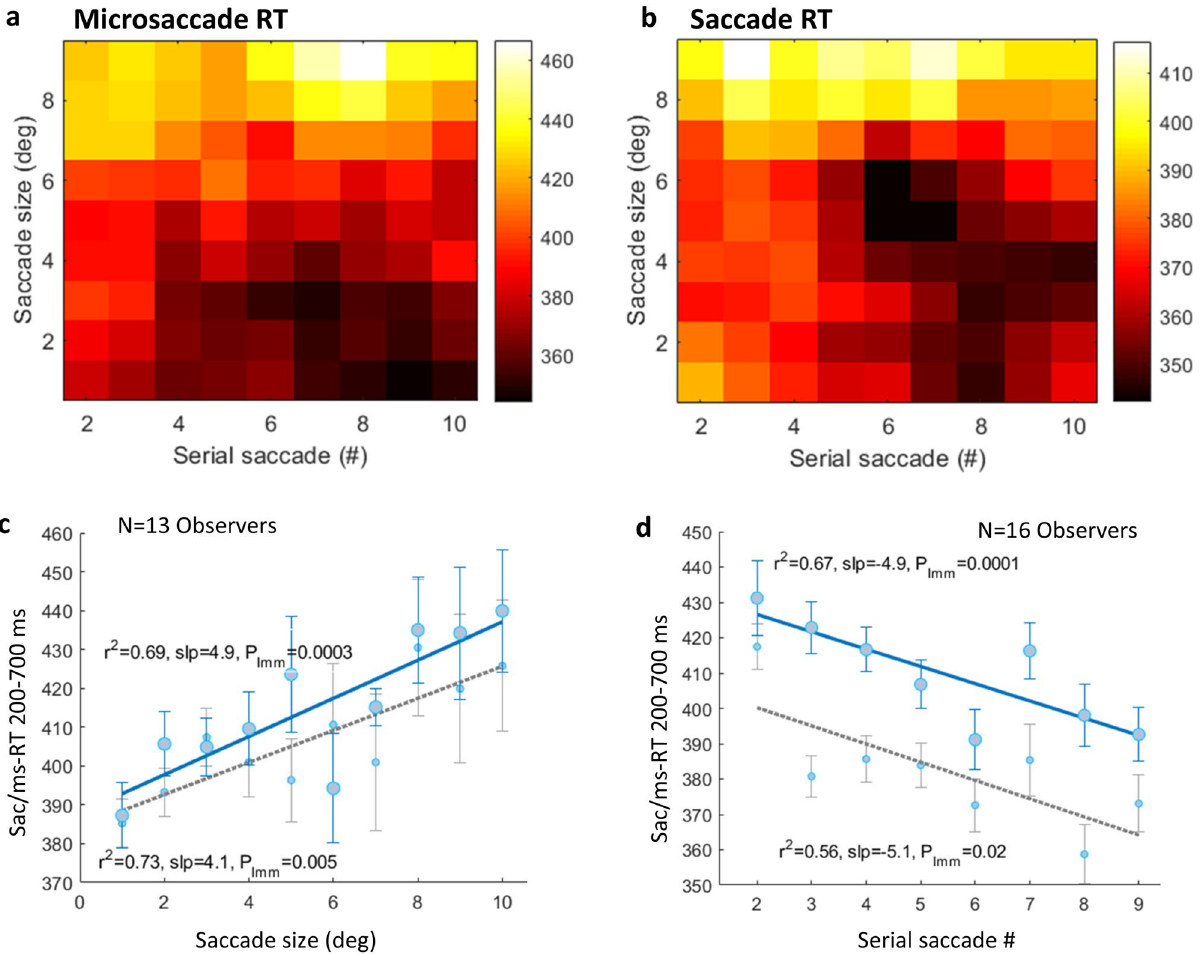
Figure 5. The results for experiment 2: Facilitation over repeated saccades and the saccade size. A fixation- related microsaccade ( a ) and saccade (from MS-free fixations) and ( b ) RTs as a function of the serial saccade number over time (X-axes) and saccade size (Y-axes). Light and dark colors represent longer and shorter RTs, respectively. 2D smoothing was applied (see the “Methods” section) and all conditions were combined for a clearer demonstration of the similar trend for msRT and sacRT. ( c ) A fixation-related saccade (blue)/ microsaccade (gray) latency (sac/ms RT) as a function of saccade distance (deg), averaged across observers (n = 13) with 1SE error bars computed on the demeaned data (see the “Methods” section). Significance was assessed using LMM (see the “Methods” section). b(slope) = 4.9, t(118) = 3.77, p ≤ 0.0003 with CI (2.3, 7.5); b(slope) = 4.1, t(118) = 2.8, p ≤ 0.005 with CI (1.2, 7), for sacRT and msRT, respectively. ( d ) A fixation-related saccade (blue)/microsaccade (gray) latency (sac/ms RT) as a function of the serial saccade number, averaged across observers (n = 16) with 1SE error bars computed on the demeaned data (see the “Methods” section). Significance was assessed using LMM (see the “Methods”); b(slope) = − 4.9, t(126) = − 3.9, p ≤ 0.0001 with CI (− 7.3, − 2.4); b(slope) = − 3, t(118) = − 2.2, p ≤ 0.02 with CI (− 5.7, − 0.3), for sacRT and msRT,